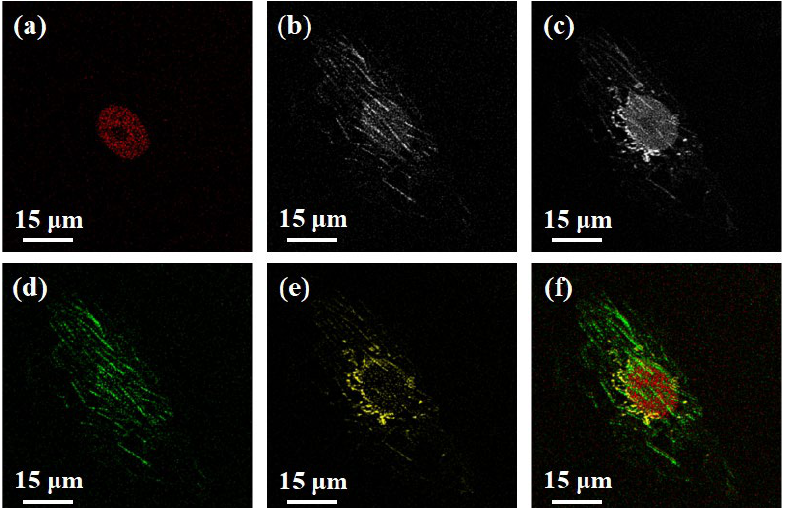
Figure 3. Three-color two-photon imaging. ( a ): nucleus; ( b ) : nucleus and microtubules; ( c ) : nu- cleus, microtubules and dictyosomes; ( d ): microtubules; ( e ): dictyosomes; ( f ): superimposed ( a ), ( d ) and ( e ). Field of view (FOV): 75 μm, scale bar: 15 μm.